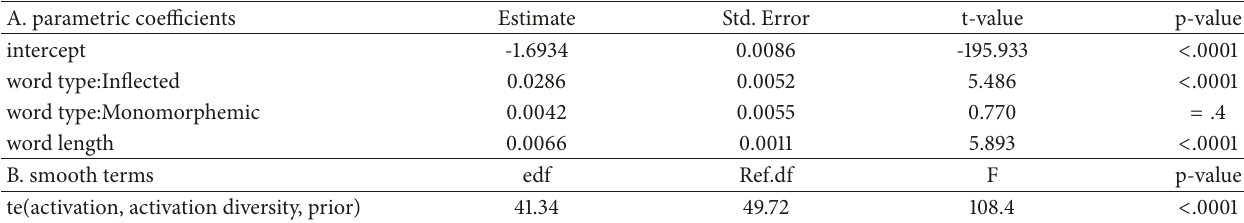
Table 6: Summary of a generalized additive model fitted to response latencies in visual lexical decision using measures from ndl. te: tensor product